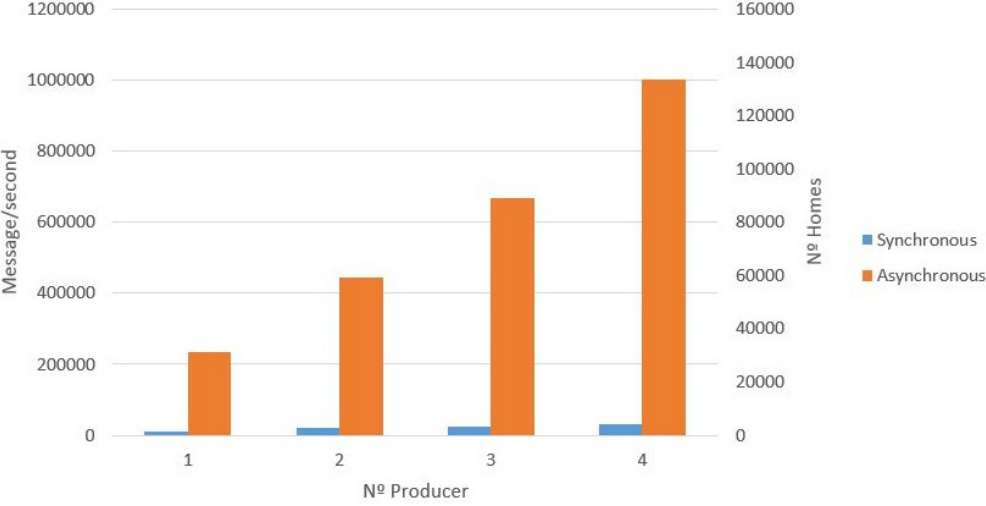
Figure 12. UIoT data producer (synchronous and asynchronous). Table 4. Query time over the event and the summarized tables.